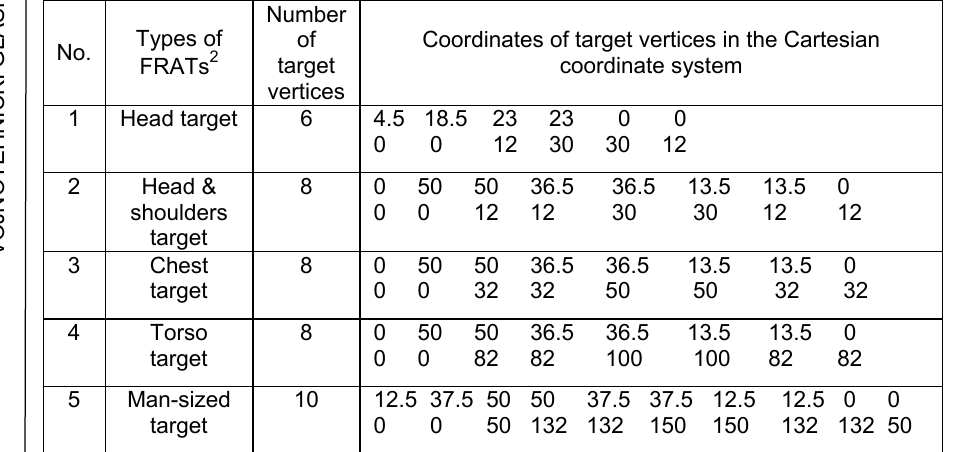
Table 1 – Coordinates of the vertices for the Soviet/Russian shooting targets Таблица 1 – Координаты вершин силуэтов советских / российских стрелковых